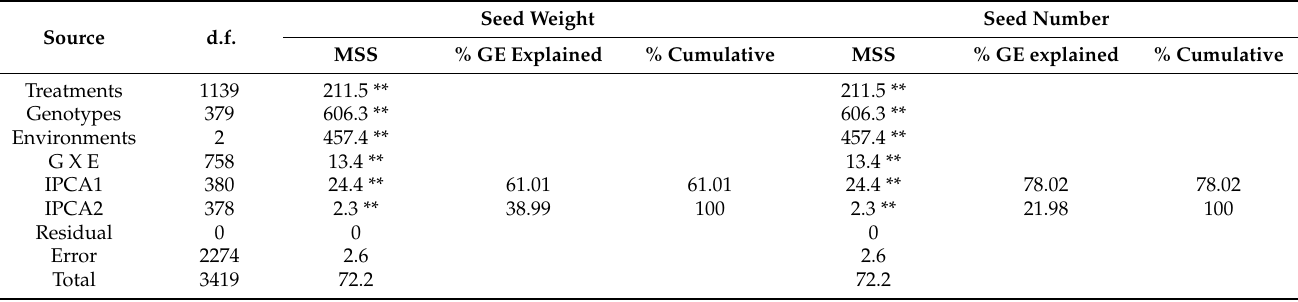
Table 3. ANOVA for AMMI2 model for seed weight and seed number.